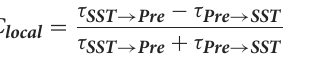
5 ◦ S) for February, April, June, August, October, and −